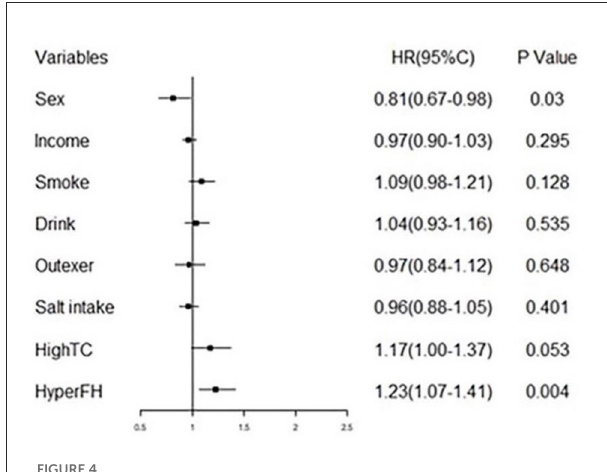
FIGURE4 Forest plot of fully adjusted variables in COX regression analysis model (model 3) shows risk of different obesity status and